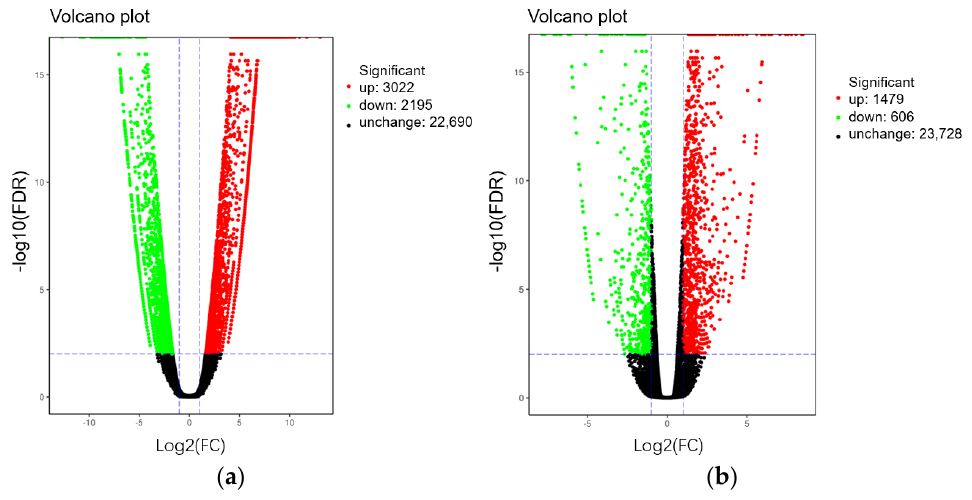
Figure 3. Volcano plot of the differentially expressed genes (DEG) of T01-vs.-T02 ( a ) and T04-vs.- T03 ( b